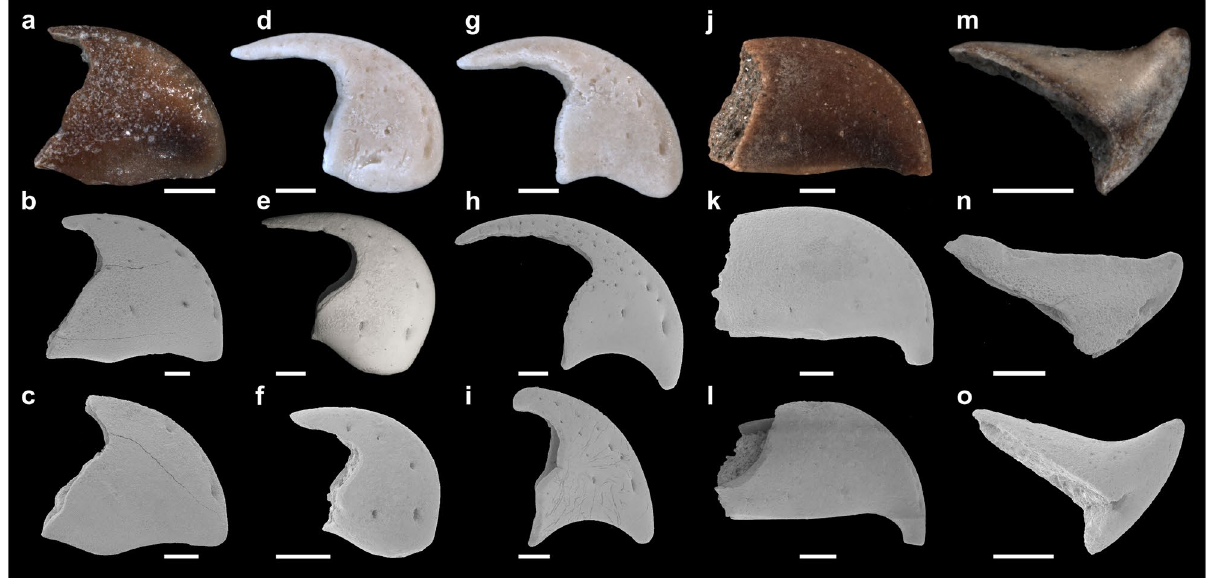
Figure 3. Morphology of selected fossil samples incorporated into this study. ( a – c ) Triangular morphotype with a short hook. ( d – f ) Triangular morphotype with a long hook and a convex margin. ( g – i ) Triangular morphotype with a long hook and a concave margin. ( j – l ) Almost rectangular morphotype with a blunt tip. ( m – o ) Morphotype with a strong blunt end. Specimens: ( a ) UMJGP 211462. ( b ) UMJGP 211458. ( c ) NHMW 2006z0343/0026. ( d ) NHMW 2016/0152/0010. ( e ) KGP-MH DU-001. ( f ) UMJGP 211446. ( g ) NHMW 2016/0152/0011. ( h ) NHMW 2016/0152/0004. ( i ) NHMW 2016/0152/0005. ( j ) UMJGP 211463. ( k ) UMJGP